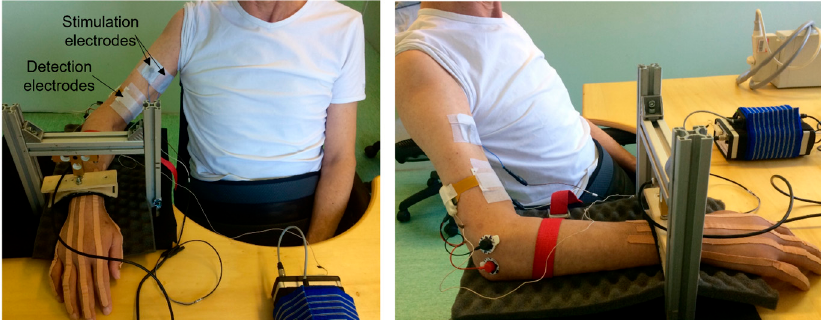
Figure 1. Frontal ( left image ) and lateral ( right image ) views of the experimental setup performed with the paretic limb of a patient. Electrodes for surface EMG detection and stimulation were positioned in the distal and proximal portions of the biceps brachii muscle, respectively. The tape attached to the patient’s fingers is for rehabilitation purposes and, therefore, is not related to the experimental protocol.